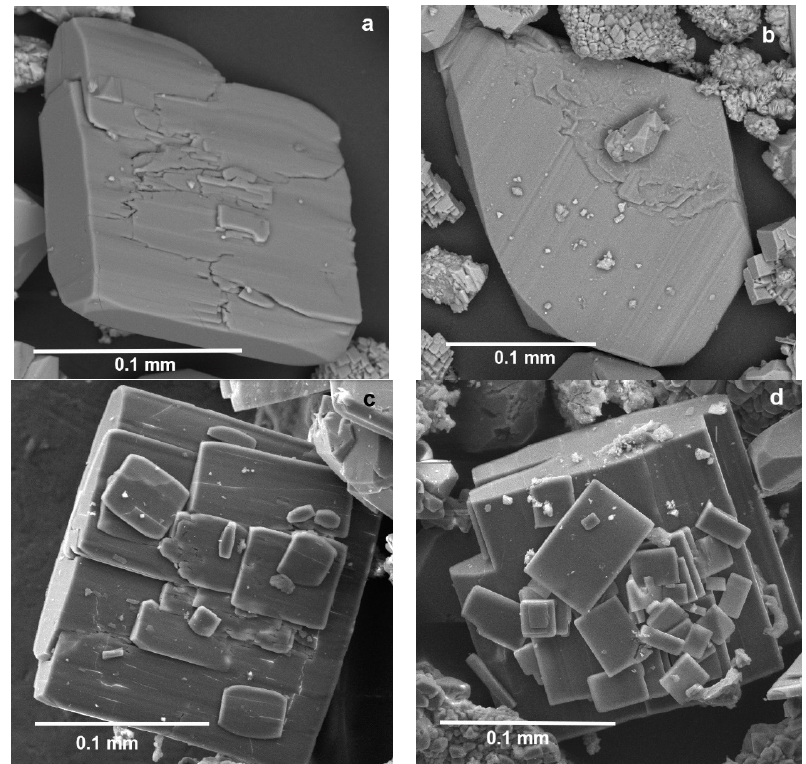
Figure 1. Separate crystals ( a , b ) and crystal clusters (( c , d ): small crystals overgrow large crystal) of krasnoshteinite. Blocky crystals of dolomite and distorted quartz crystal are observed in (b).